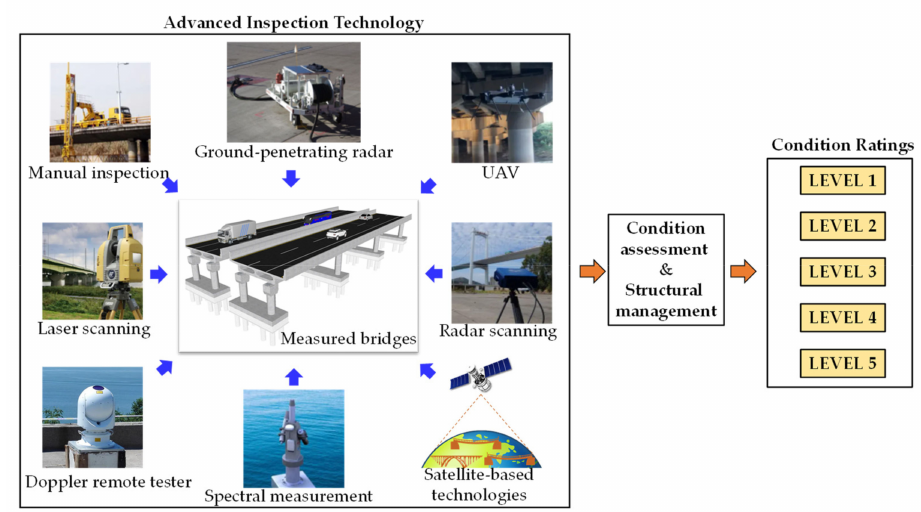
Figure 1. Condition ratings with the advanced bridge inspection technologies.